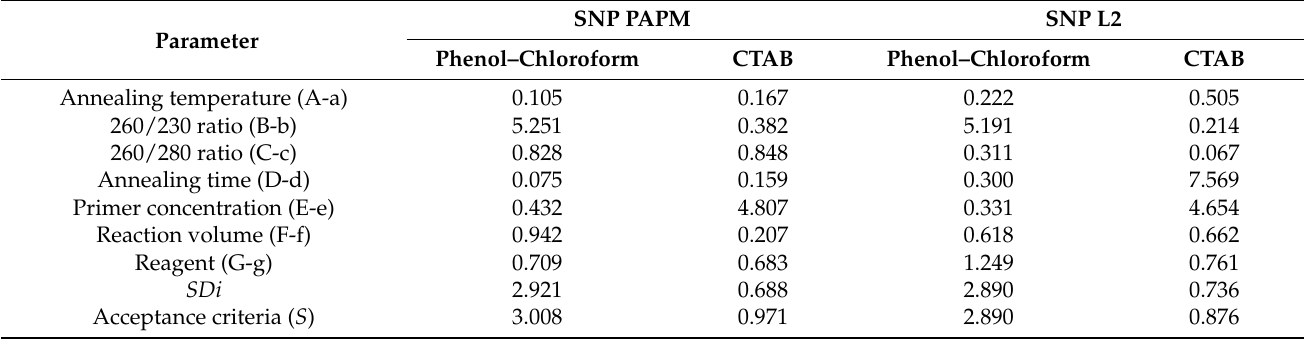
Table 8. Robustness. Differences ( ∆ = X-x), between each of the selected parameters by SNP and extraction method.